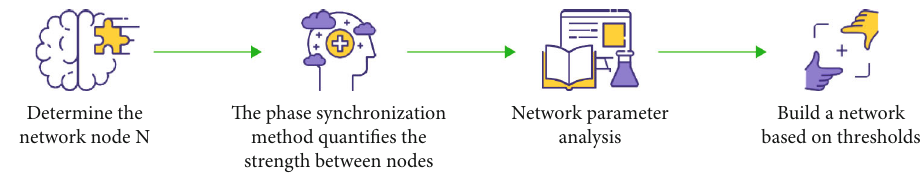
Figure 2: Brain functional network analysis fl ow based on EEG signals. Table 1: Characteristic parameters of brain functional network based on positive correlation coe ffi